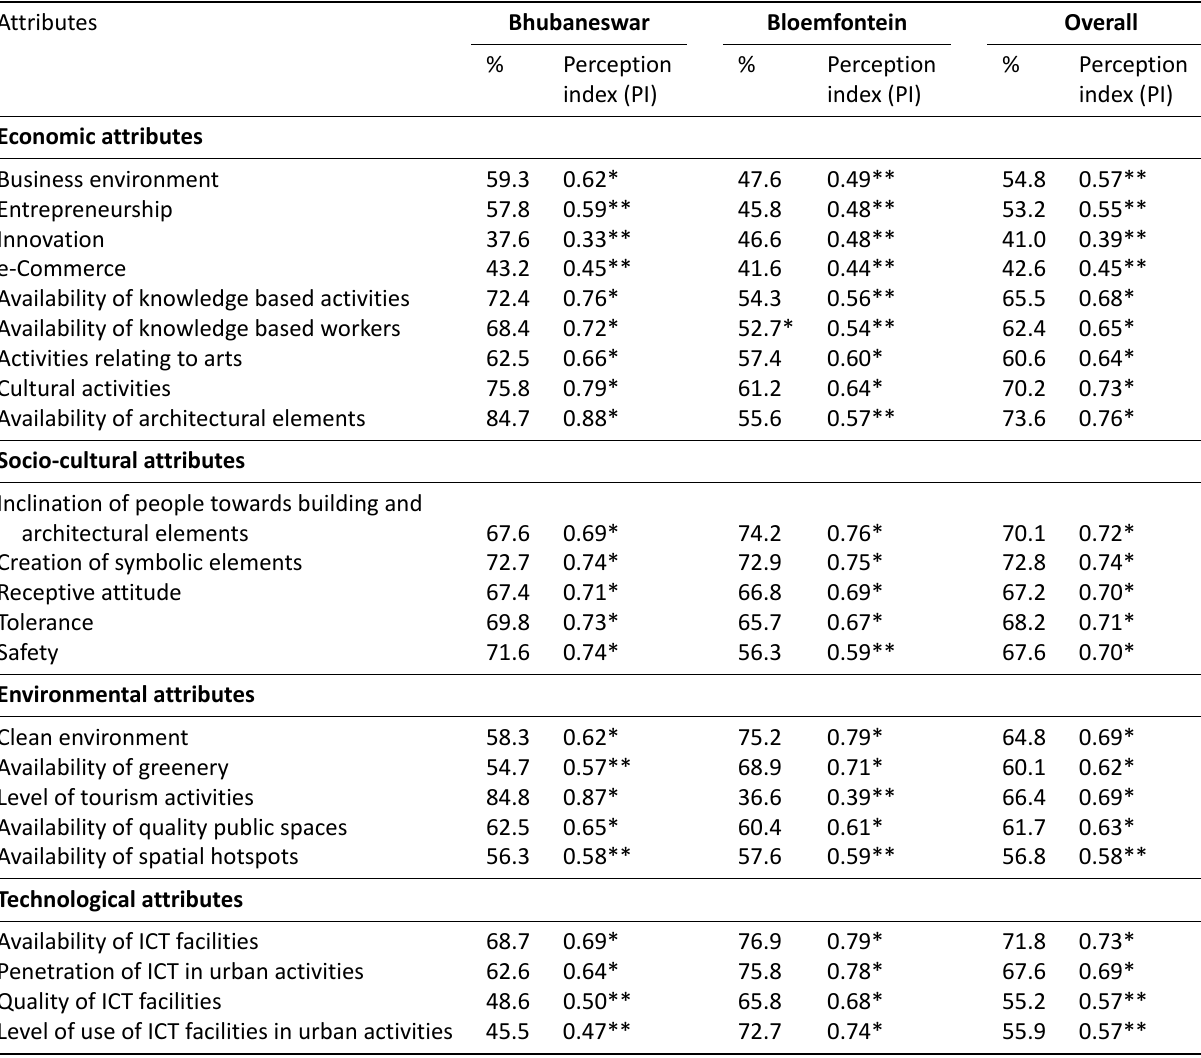
Table 2. Level of influence of socio-economic, environmental and technological variables in developing an image of creative